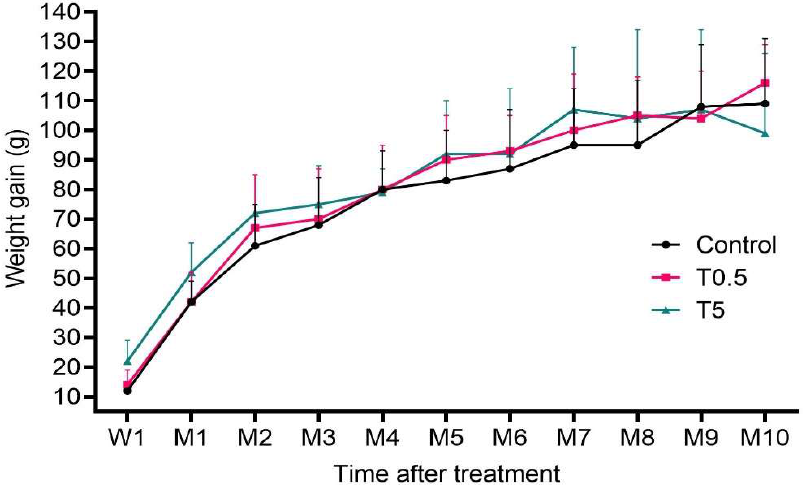
Figure 3. Mean (± SD) weight gain (g) per group of animals after the first week (W1) and over 10 months (M) of the experiment. There was no significant difference among groups ( p >